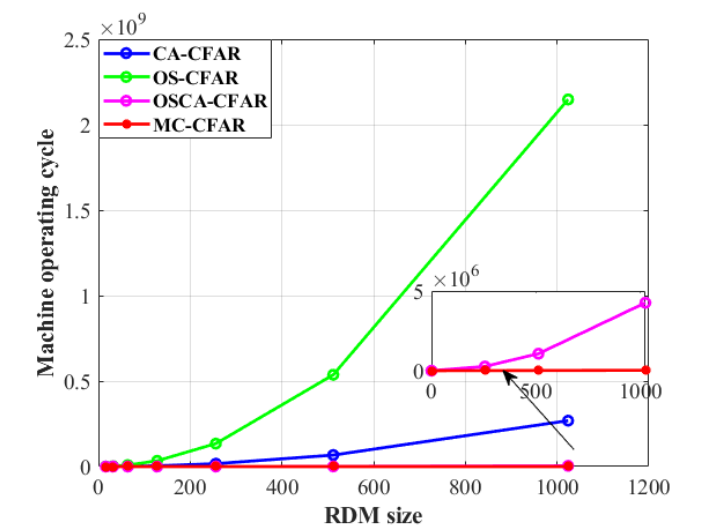
Figure 15. The relationship between the time complexity of the algorithm and the size of the detection